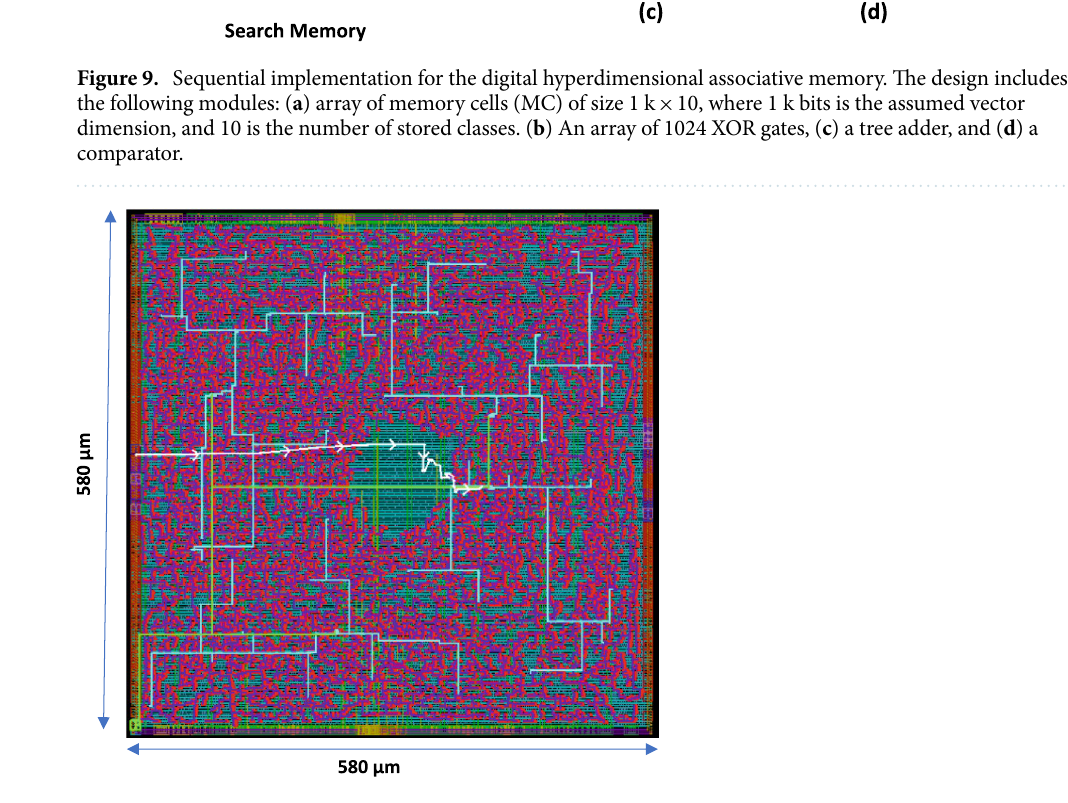
Figure 10. The layout of the ASIC-flow design for the digital AM. It includes the chip area utilization and the critical